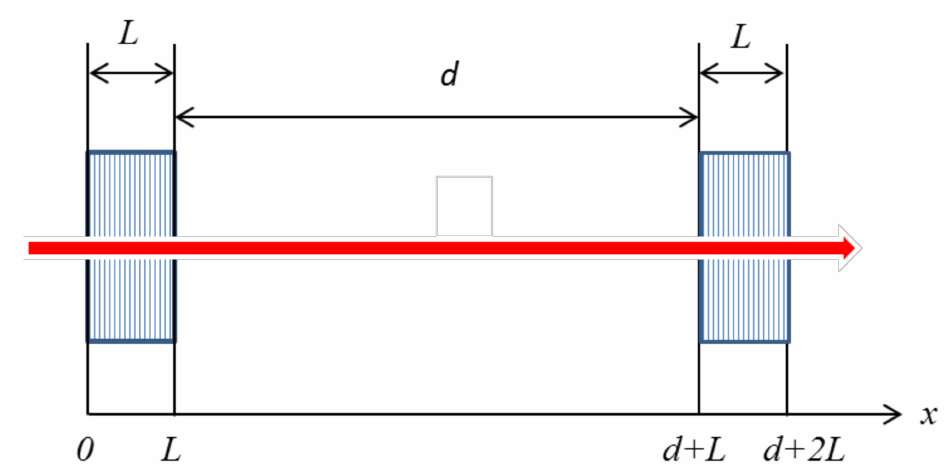
Figure 1. Fabry–Perot resonator with periodic structures as reflecting